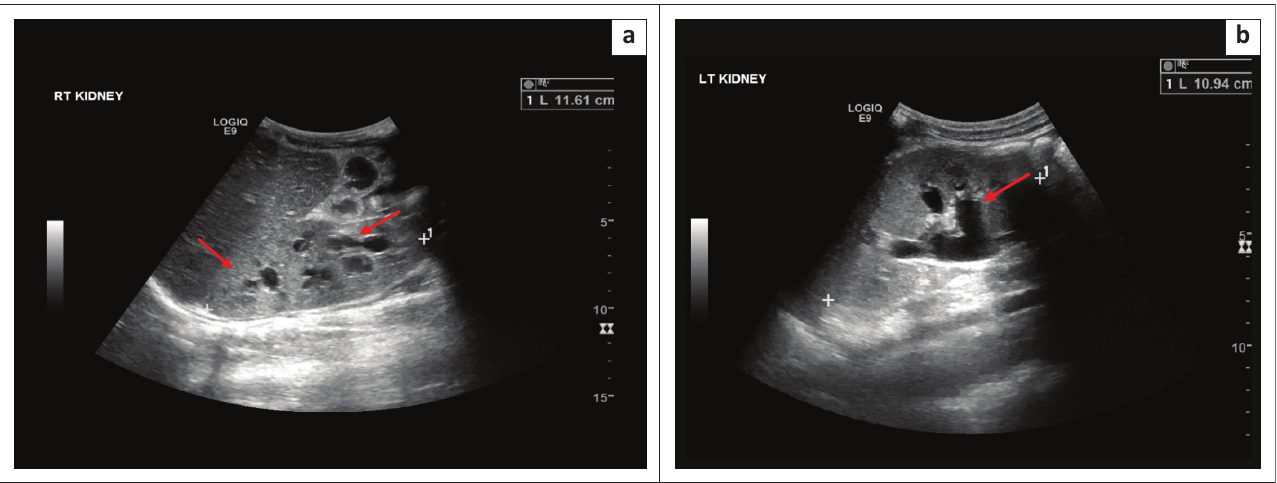
FIGURE 2: Ultrasound of the right kidney (a) and left kidney (b) demonstrating bilateral hydronephrosis and enlarged kidneys.